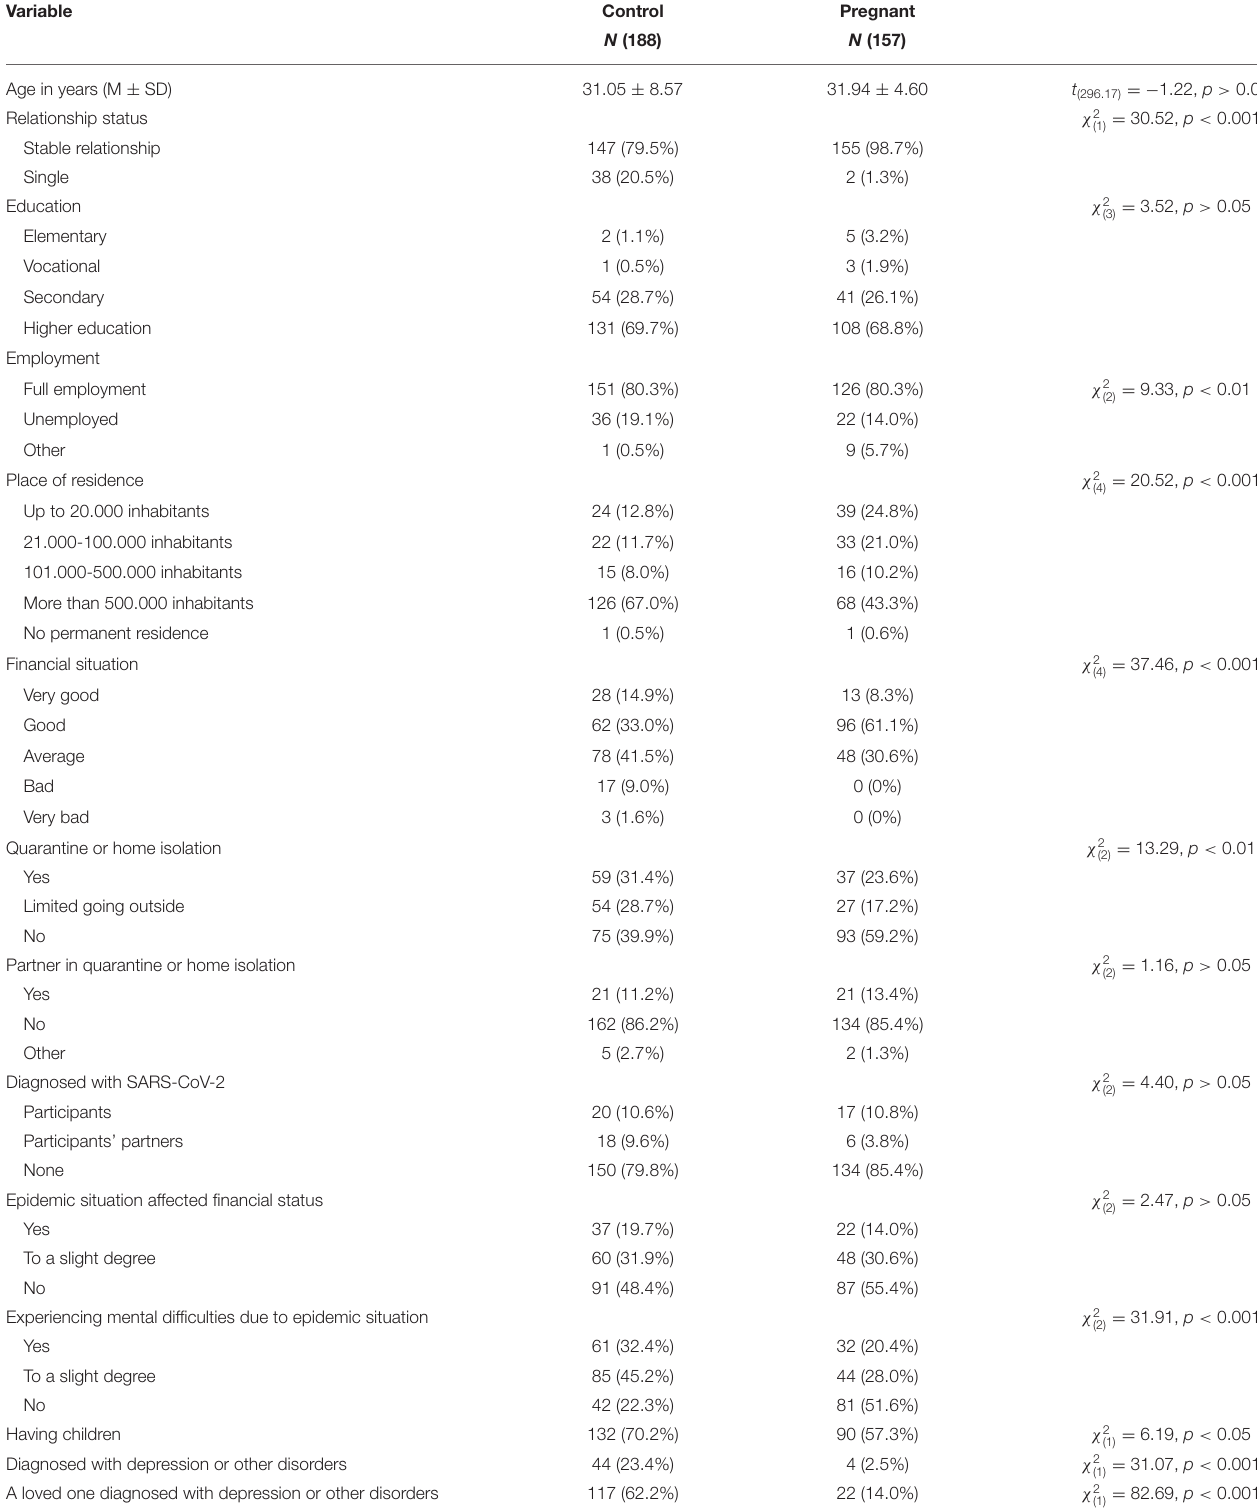
TABLE 1 | Sociodemographic variables in the two study samples of women ( N =